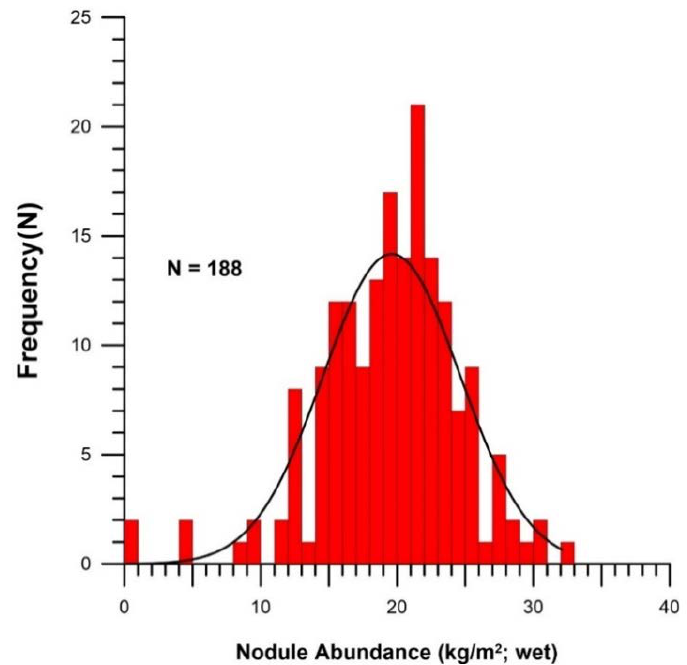
Figure 4. Histogram of nodule abundance used as training data in Area E1, proving its normal (Gaussian) distribution. Mean value is 19.2 kg/m 2 , with a standard deviation of 6.8 kg/m 2 and a coefficient of variation of 36%. The slight skewness towards small values is caused by a few very low abundance values.